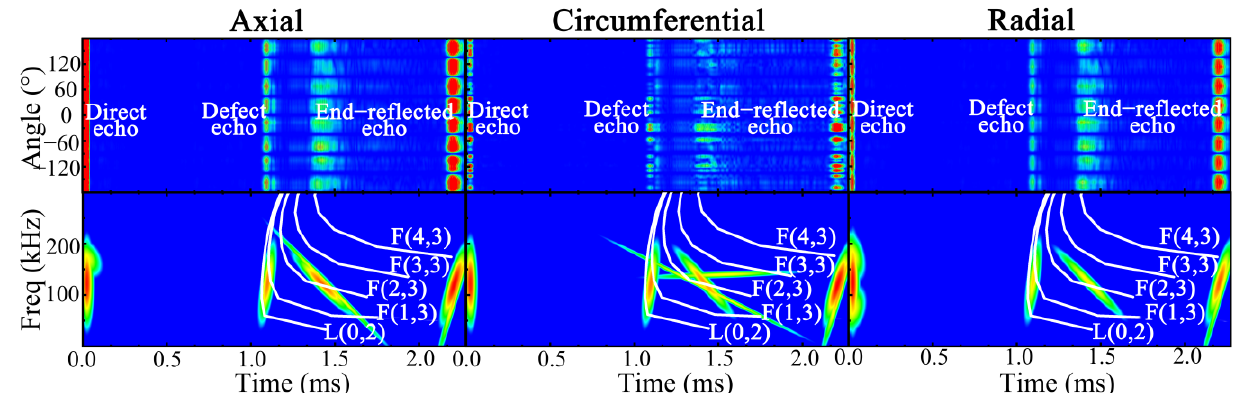
Figure 12. Time–frequency diagrams of simulated UGW signals (axial, circumferential and radial) with defect 1 ( α = 300°).